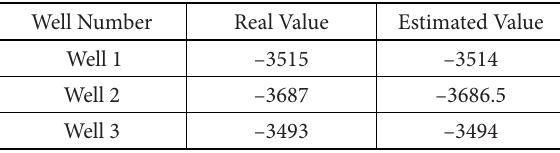
Table 3. Comparison real value and estimated value by the